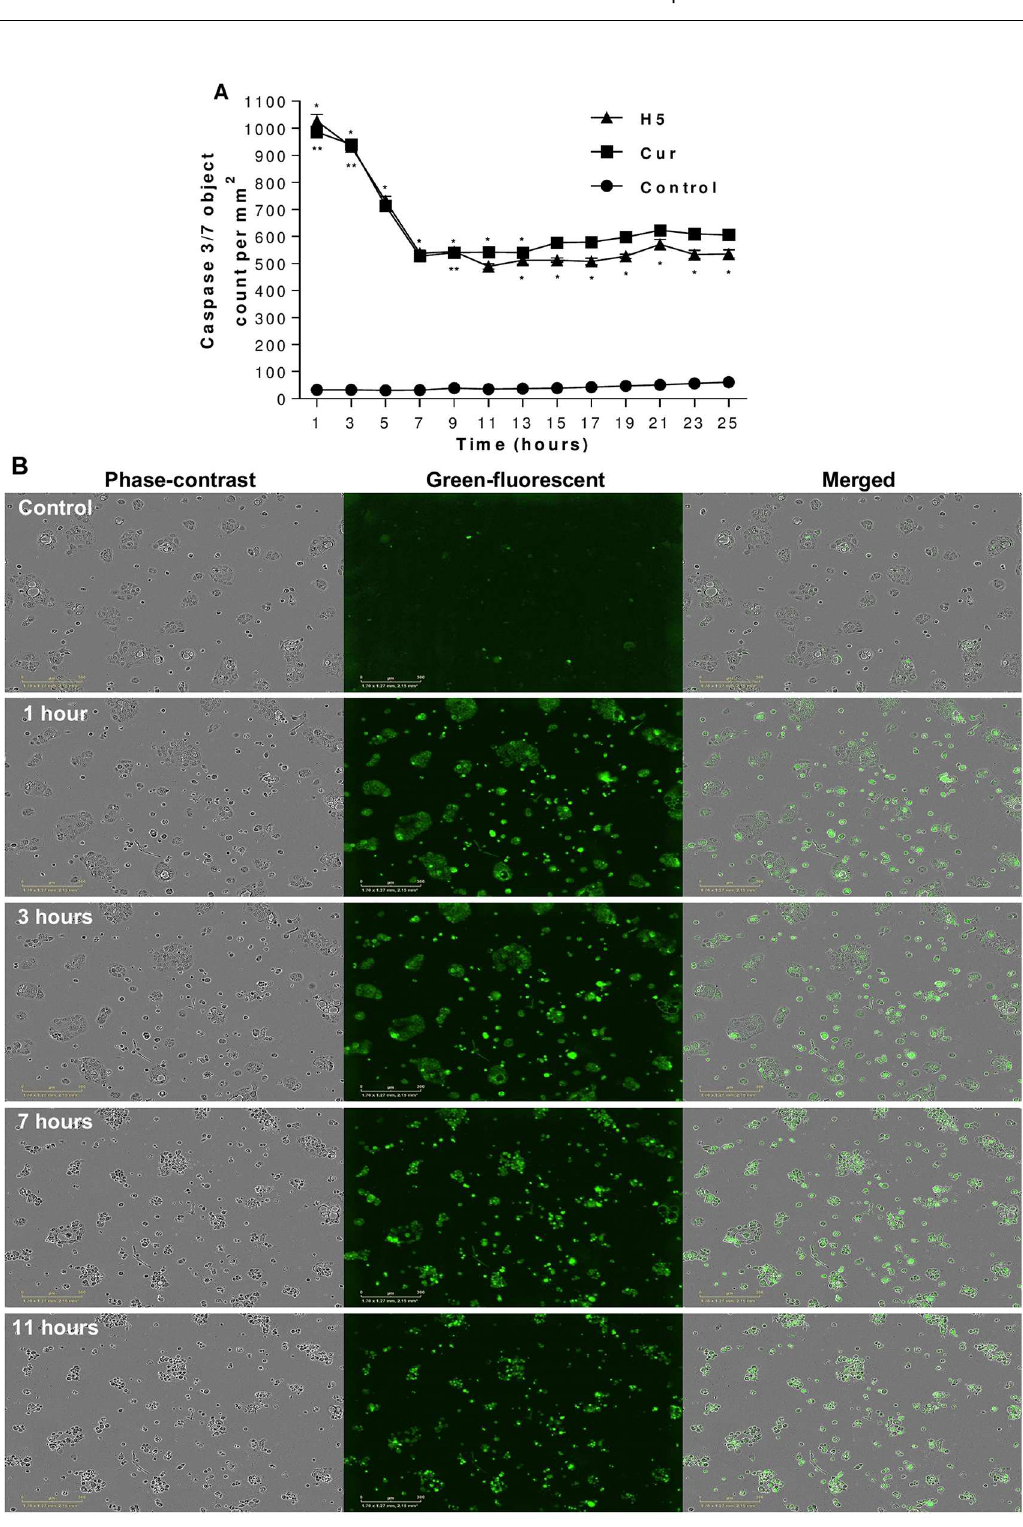
Fig 8. Effect of curcumin treatment on caspase-3/7 activity and morphological changes in BxPC-3 cells. BxPC-3 cells were treated with free curcumin and the H5 formulation containingcurcumin, with the effective curcumin concentration equivalent to the IC50 in both cases. Caspase-3/7 activity (A) , with morphologicalchangesin real-time using phase-contrast and green fluorescence images showingapoptosis (B) . The data are shown as the mean ± SD of three independent replicates.Statistical analysisby unpairedstudent t -test: * p < 0.05; ** p < 0.001.Scale bar: represents 300 μ